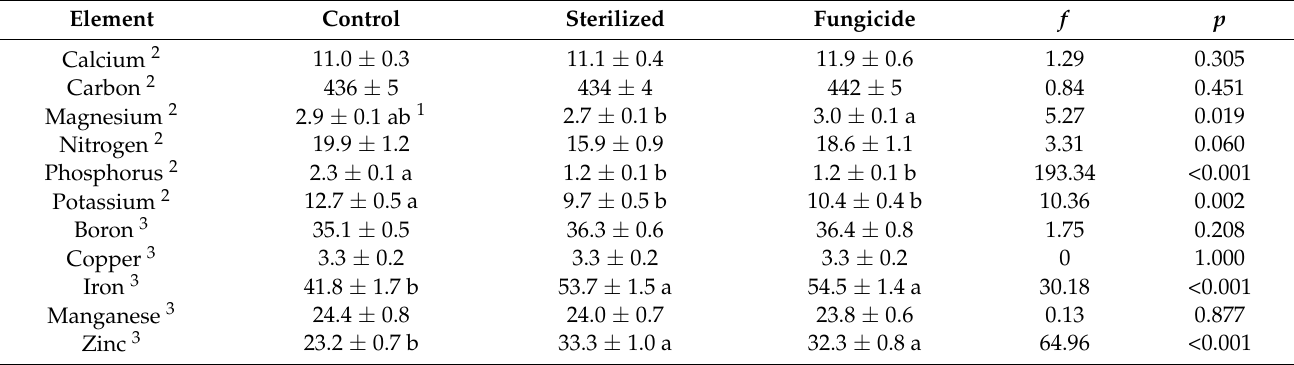
Table 4. The influence of growing Serianthes kanehirae plants in soil obtained from Serianthes nelsonii rhizosphere on leaf chemistry. Mean ± SE, n =